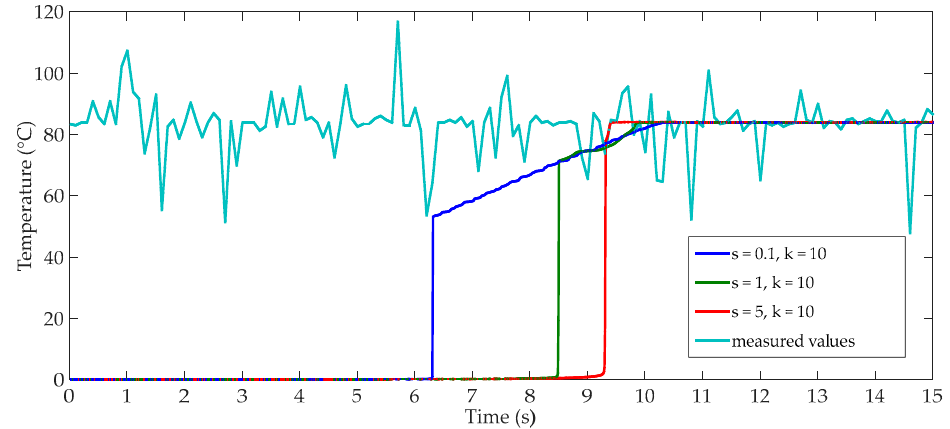
Figure 11. Filtering of the noisy measured variable for different sensitivity of the membership function.